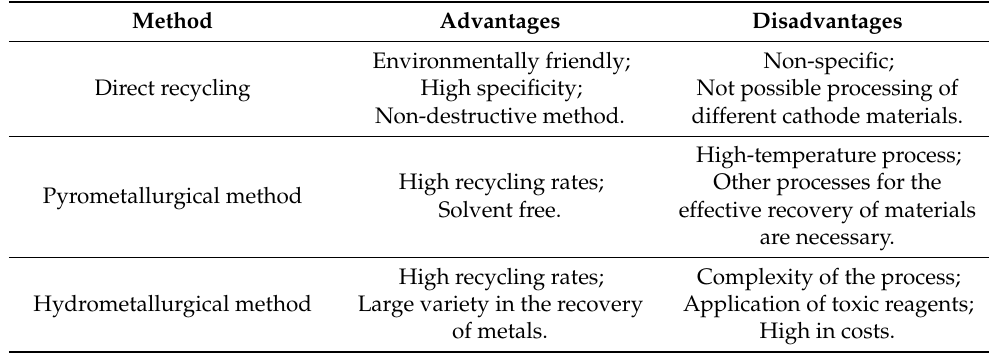
Table 4. Comparison of used recycling techniques. Reprinted from Energy Storage Materials, Vol. 37, Costa et al. [21], Recycling and environmental issues of lithium-ion batteries: Advances, challenges and opportunities, pp. 433–465, Copyright (2022), with permission from